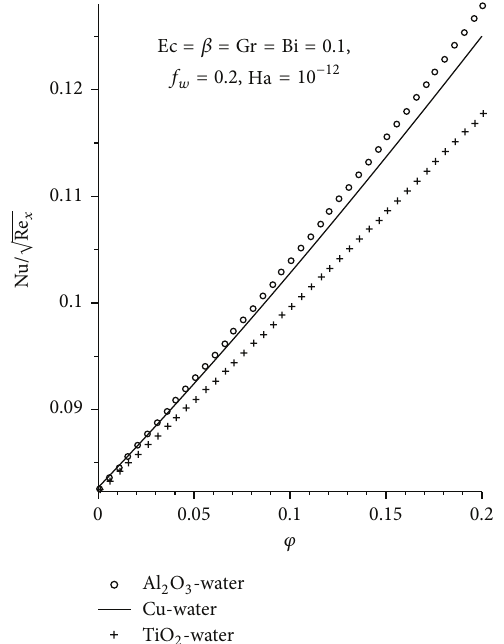
Figure 11: Local Nusselt number for different nanofluids.